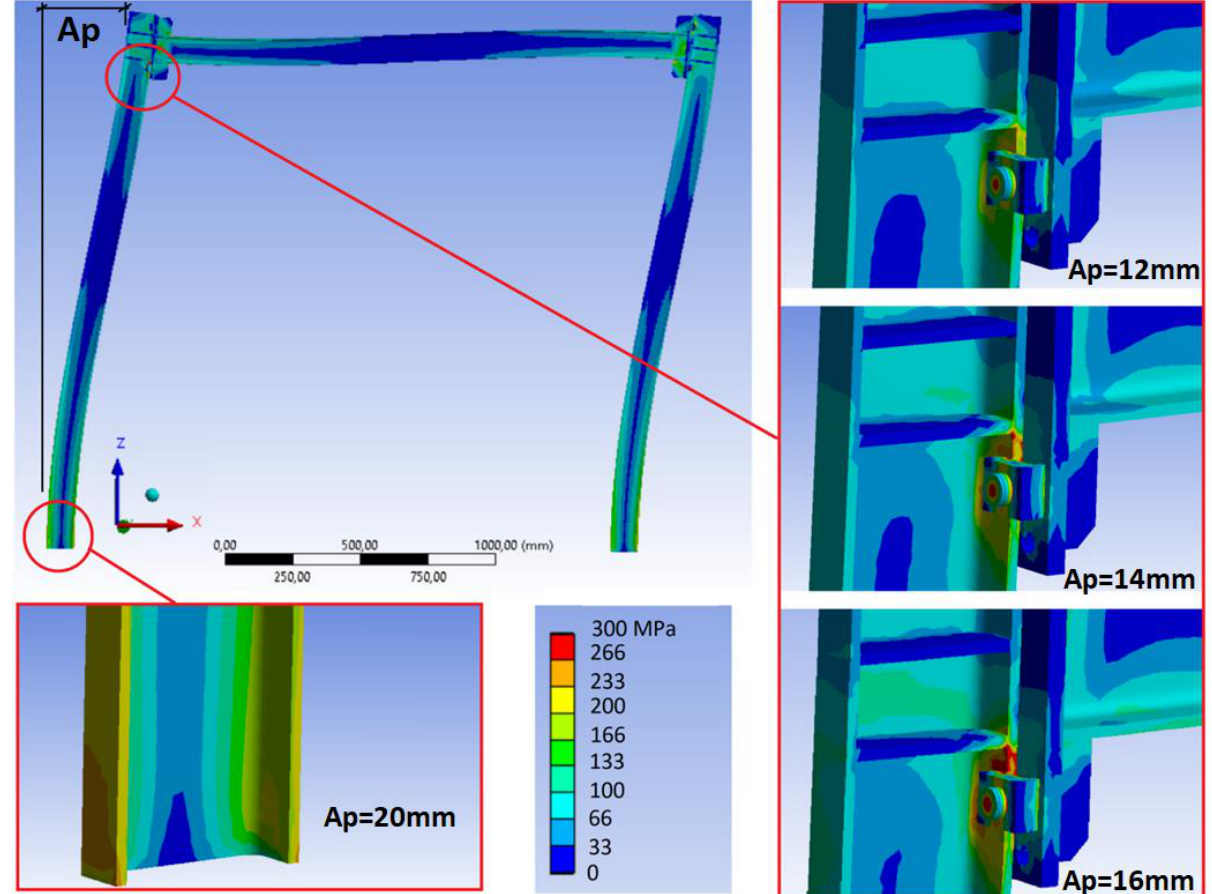
Figure 8. Areas of maximum stress for displacement values in the frame top of Ap = 12, 14, 16 mm, and the exceeded material ’ s yield strength at the bottom of the frame column when Ap = 20 mm.